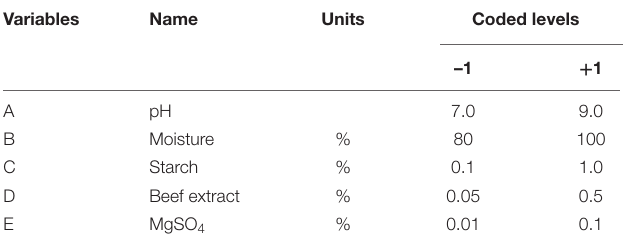
TABLE 2A | Factors and their levels of independent